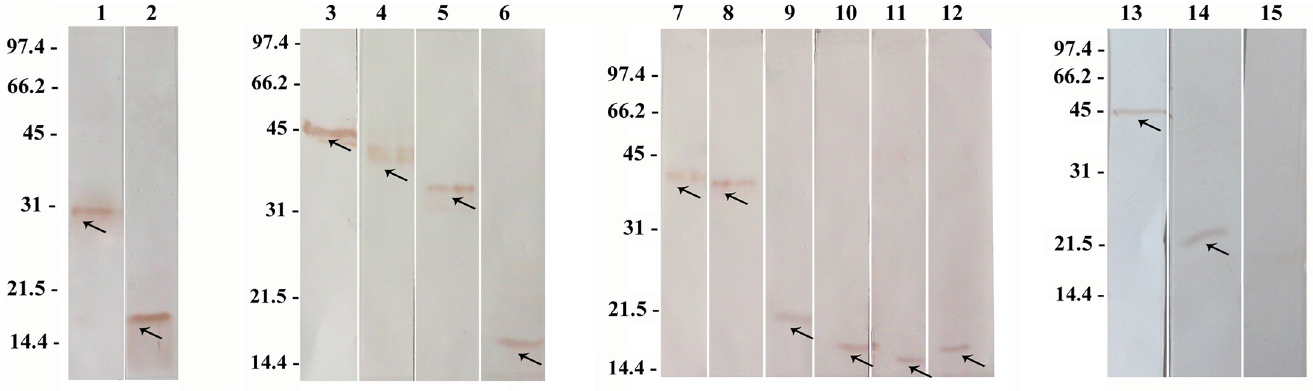
Fig 1. Confirmation of Ph . sergenti salivary proteins expression in supernatant of COS-7 cell culture using western blot analysis by anti-His antibody. COS-7 cell lines were transiently transfected with recombinant plasmids encoding for fourteen Ph . sergenti salivary proteins. Forty-eight h after transfection, the supernatants were subjected to western blot analysis using anti-His antibody. Line 1. VR1020-PsSP7 (MW, 30.4 KDa), line 2. VR1020-PsSP9 (17.8 KDa), line 3. VR1020-PsSP20 (46.1 KDa), line 4. VR1020-PsSP42 (39.6 KDa), line 5. VR1020-PsSP52 (32.5 KDa), line 6. VR1020-PsSP54 (18.4 KDa), line 7. VR1020-PsSP40 (39.3 KDa), line 8. VR1020-PsSP41 (37.4 KDa), line 9. VR1020-PsSP14 (20.8 KDa), line 10. VR1020-PsSP15 (18.4 KDa), line 11. VR1020-PsSP73 (16 KDa), line 12. VR1020-PsSP98 (18 KDa), line 13. VR1020-PsSP26 (46.2 KDa), line 14. VR1020-PsSP44 (24.8 KDa), line 15.